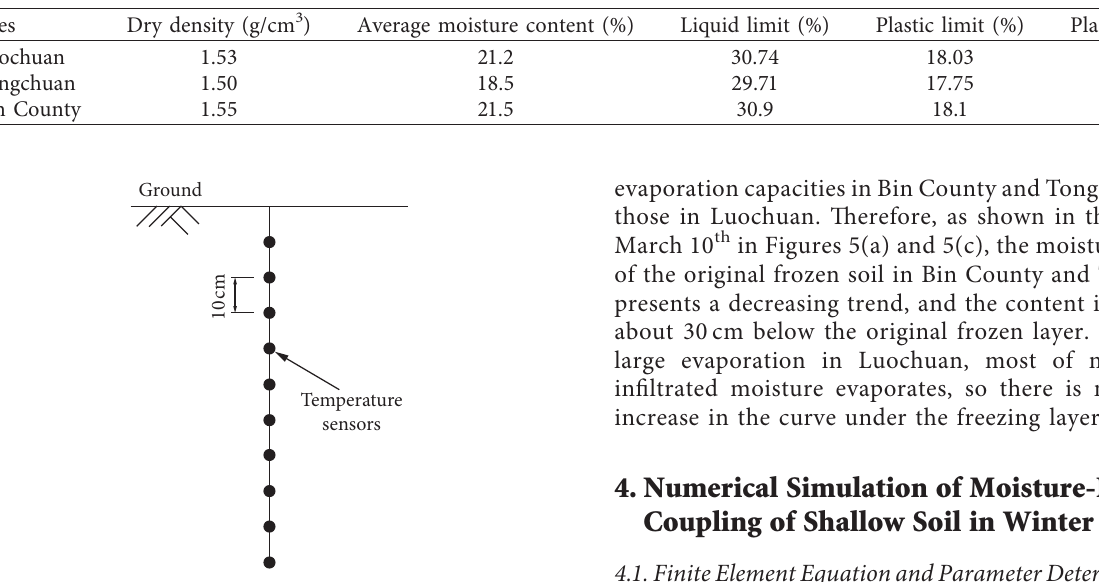
Table 1: Basic physical index.